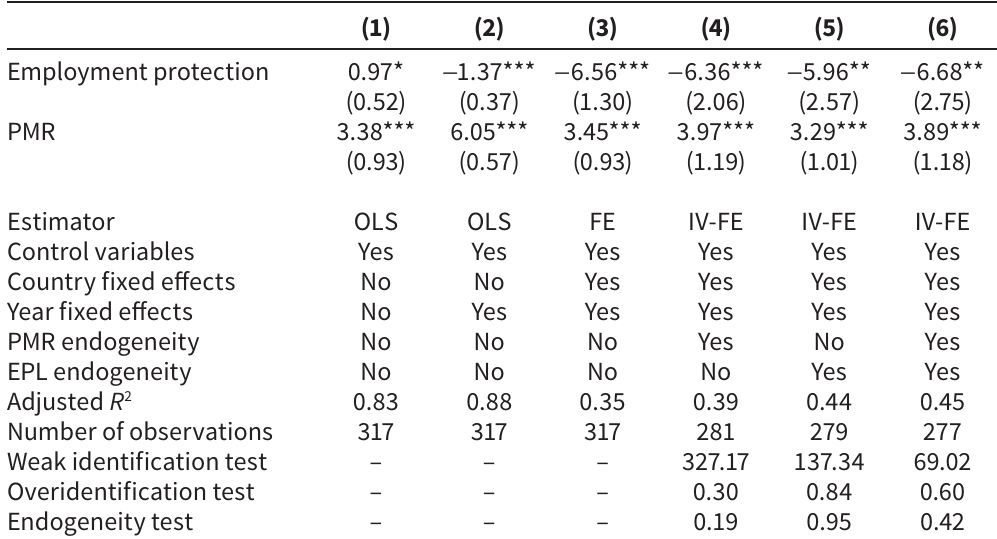
Impact of EPL and PMR on the unemployment rate